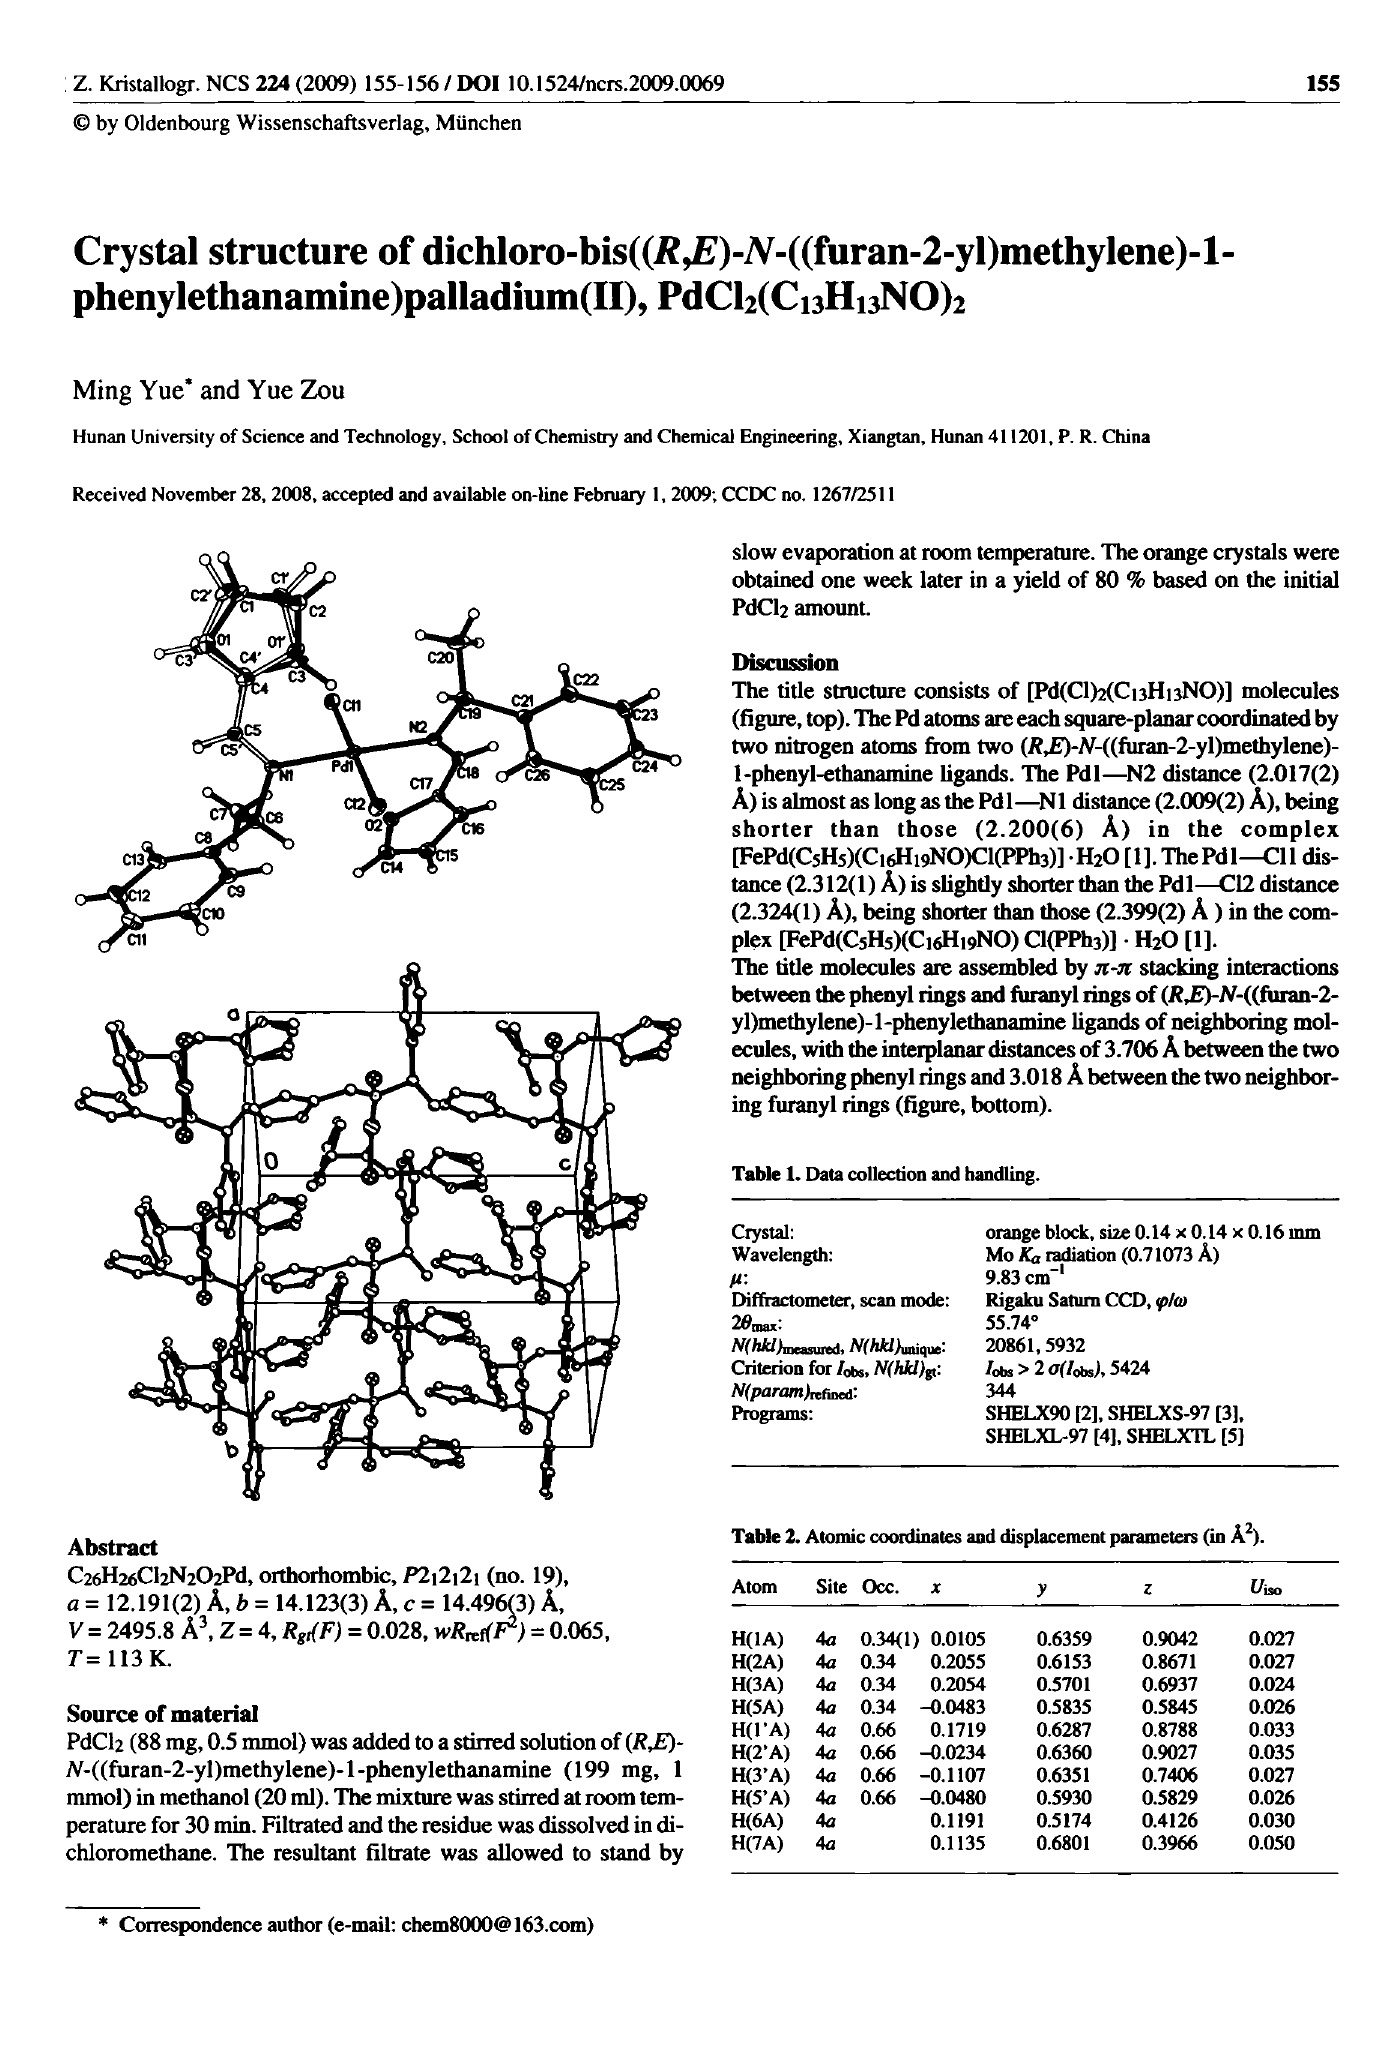
Table 2. Atomic coordinates and displacement parameters (in Â 2